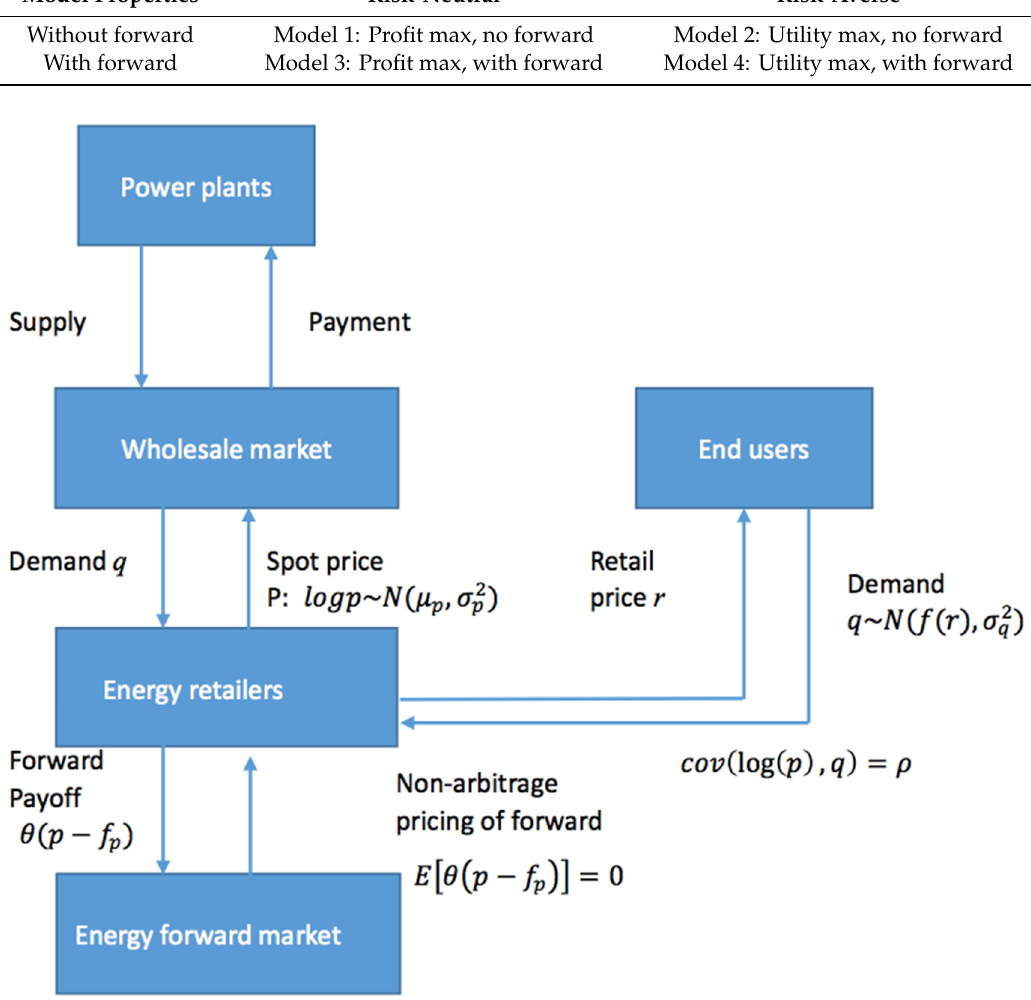
Figure 1. The structure of the energy market in models 3 and 4. It involves three markets: wholesale market, retail market, and energy financial market. If we remove the energy forward market, we obtain the market structure for models 1 and 2. We assumed no-arbitrage pricing of forward, i.e., 𝐸[𝜃(𝑝 − 𝑓 (cid:3043) )] = 0